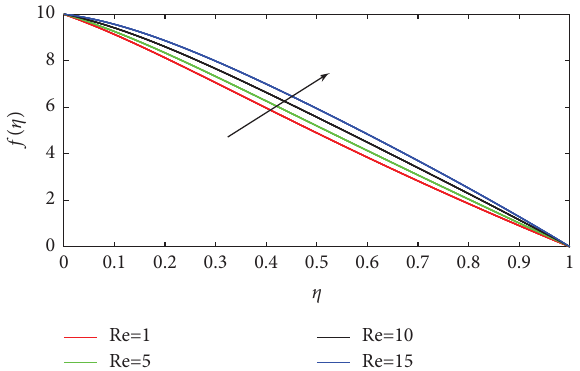
Figure 3: Velocity profles for the diferent values of Re.